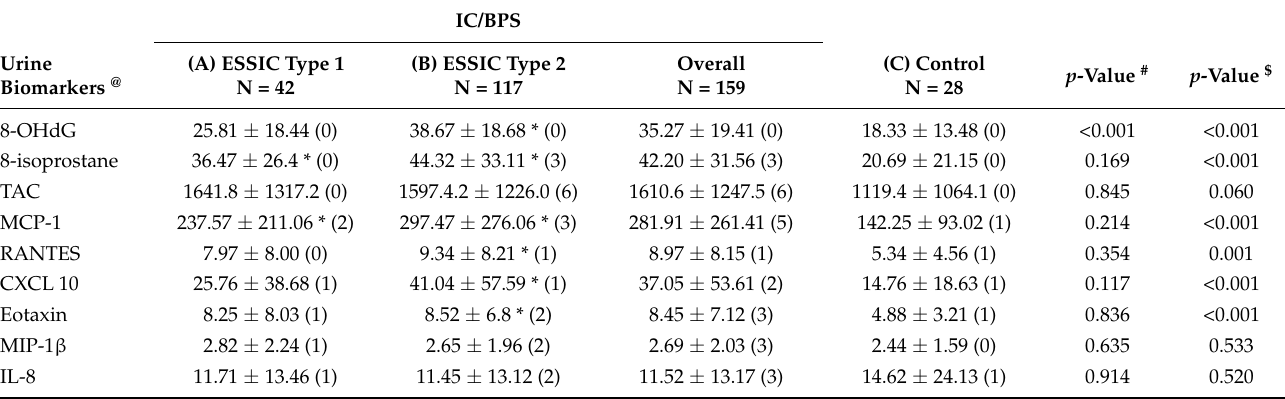
Table 2. Levels of urine biomarkers between IC/BPS and control groups. IC/BPS